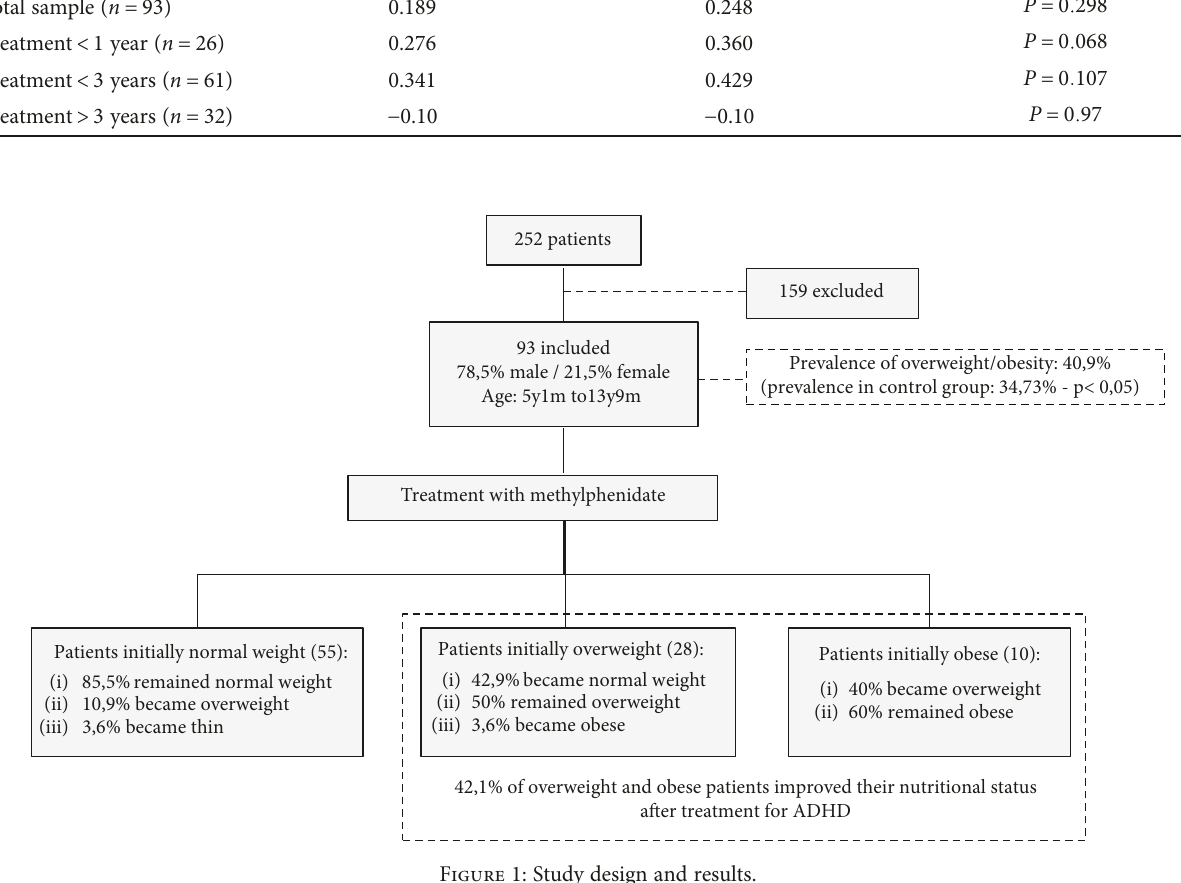
Figure 1: Study design and